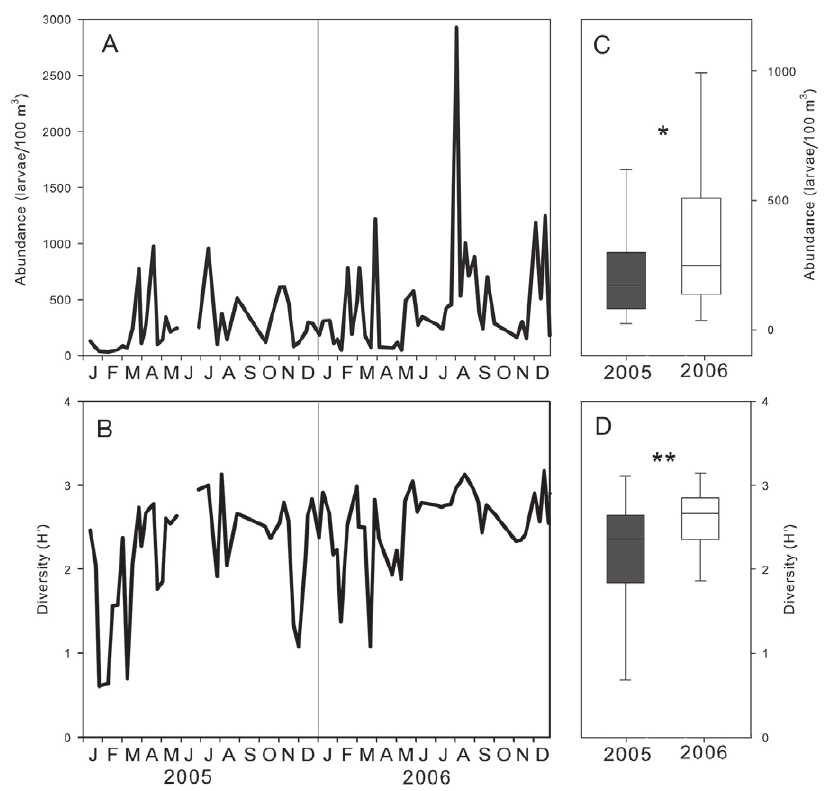
Fig. 3. – Temporal variation of the abundance (larvae/100 m 3 ) (a) and Shannon–Wiener diversity index (H’) (b) of decapod larvae. Boxplots show yearly comparisons of abundance (c) and diversity (d). In each boxplot, the median (solid line) is indicated in the centre of the box and the edges of the box are the 25th and 75th percentiles; whiskers extend to the most extreme data points that were not considered to be outliers. Results from the Student t test are highlighted as follow: * p<0.05, ** p<0.01.